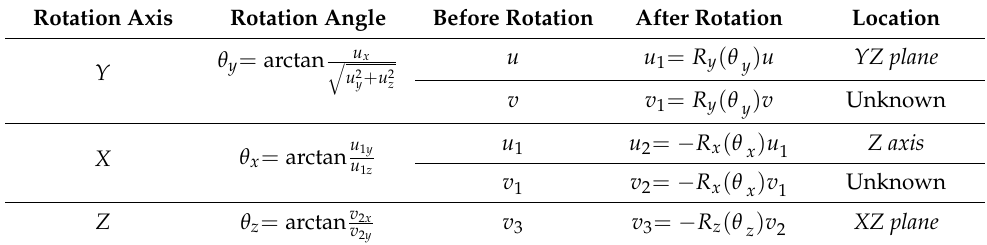
Figure 6. ( a ) The multiple dendrites (at solidification time of 110 s) segmented from V2 of Figure 2e. ( b ) A single turquoise-colored dendrite selected from ( a ). ( c ) Orthogonal plane section through the primary arm and secondary arm of the turquoise dendrite, and the unit vectors that constitute the local co-ordinate ( u , u ’, v ’) of the dendrite. ( d ) The global co-ordinate ( X, Y, Z ), and how the dendrite’s local co-ordinate information was mapped onto the global system. ( e ) Simulated multiple dendrites corresponding to the experimental dendrites shown in ( a ), ( f , g ) comparison between a single dendrite evolution from an experiment ( f row) and the corresponding simulated dendrite ( g row), S 1 –S 3 are the three orthogonal planes of α -Al. Table 1. The rotation of local dendrite axis to the global